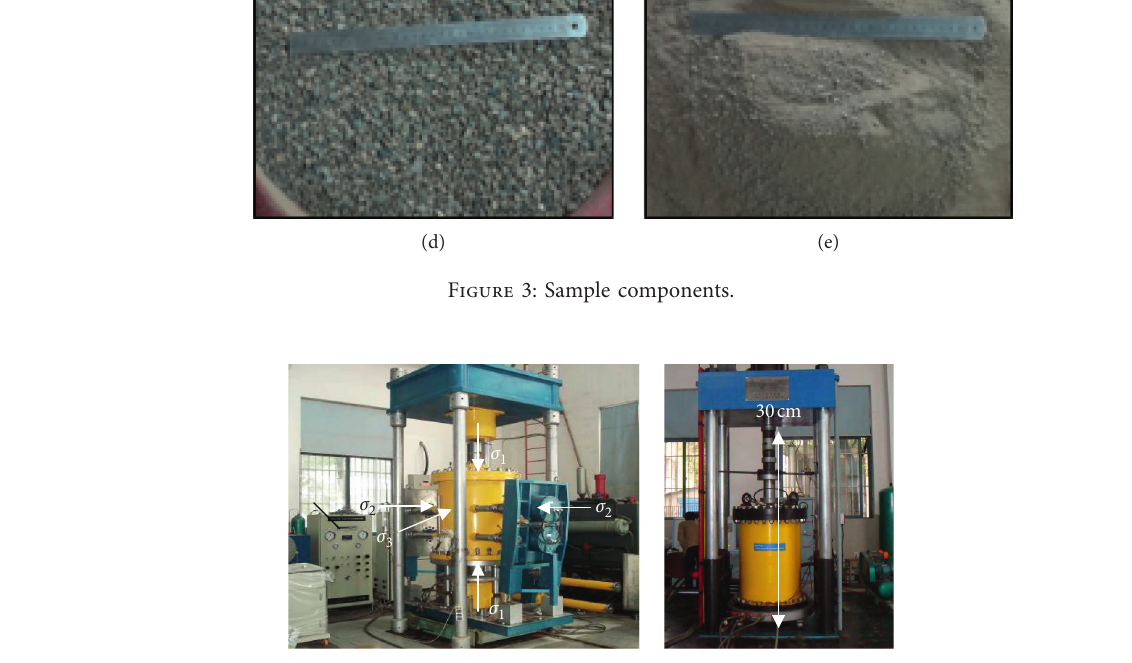
Figure 4: Test apparatus: (a) the true triaxial apparatus; (b) the conventional triaxial apparatus